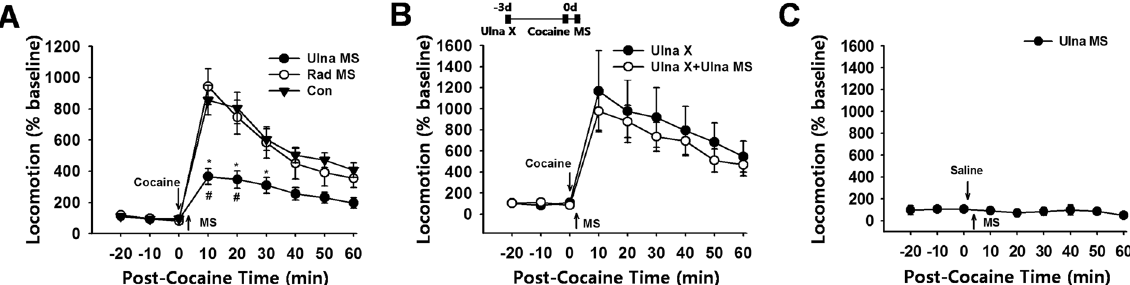
Figure 1. Mechanical stimulation of the ulnar nerve suppresses cocaine-induced locomotor activity. ( A ) Mechanical stimulation (MS) of the ulnar site (Ulna MS; n = 6) significantly attenuated the locomotor response to cocaine, compared to the control group that received cocaine only (Con; n = 6) * p < 0.05 vs. Con; # p < 0.05 vs. Rad MS. Mechanical stimulation of the radial site (Rad MS; n = 6) did not alter cocaine-induced locomotion. ( B ) The inhibitory effect of ulnar MS on cocaine locomotion was not observed in rats with ulnar nerve injury (Ulna X + Ulna MS; n = 8) when compared to control rats with ulnar nerve injury (Ulna X; n = 8). The term ‘X’ denotes lesion or injury. ( C ) Ulna MS did not affect locomotion in the control rats injected with saline (Ulna MS; n =